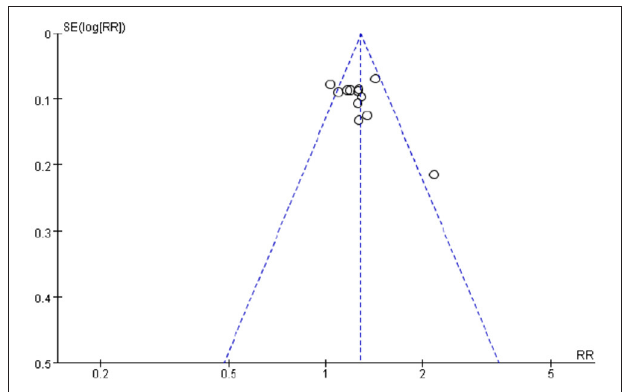
FIGURE 6 | Funnel plots showed publication